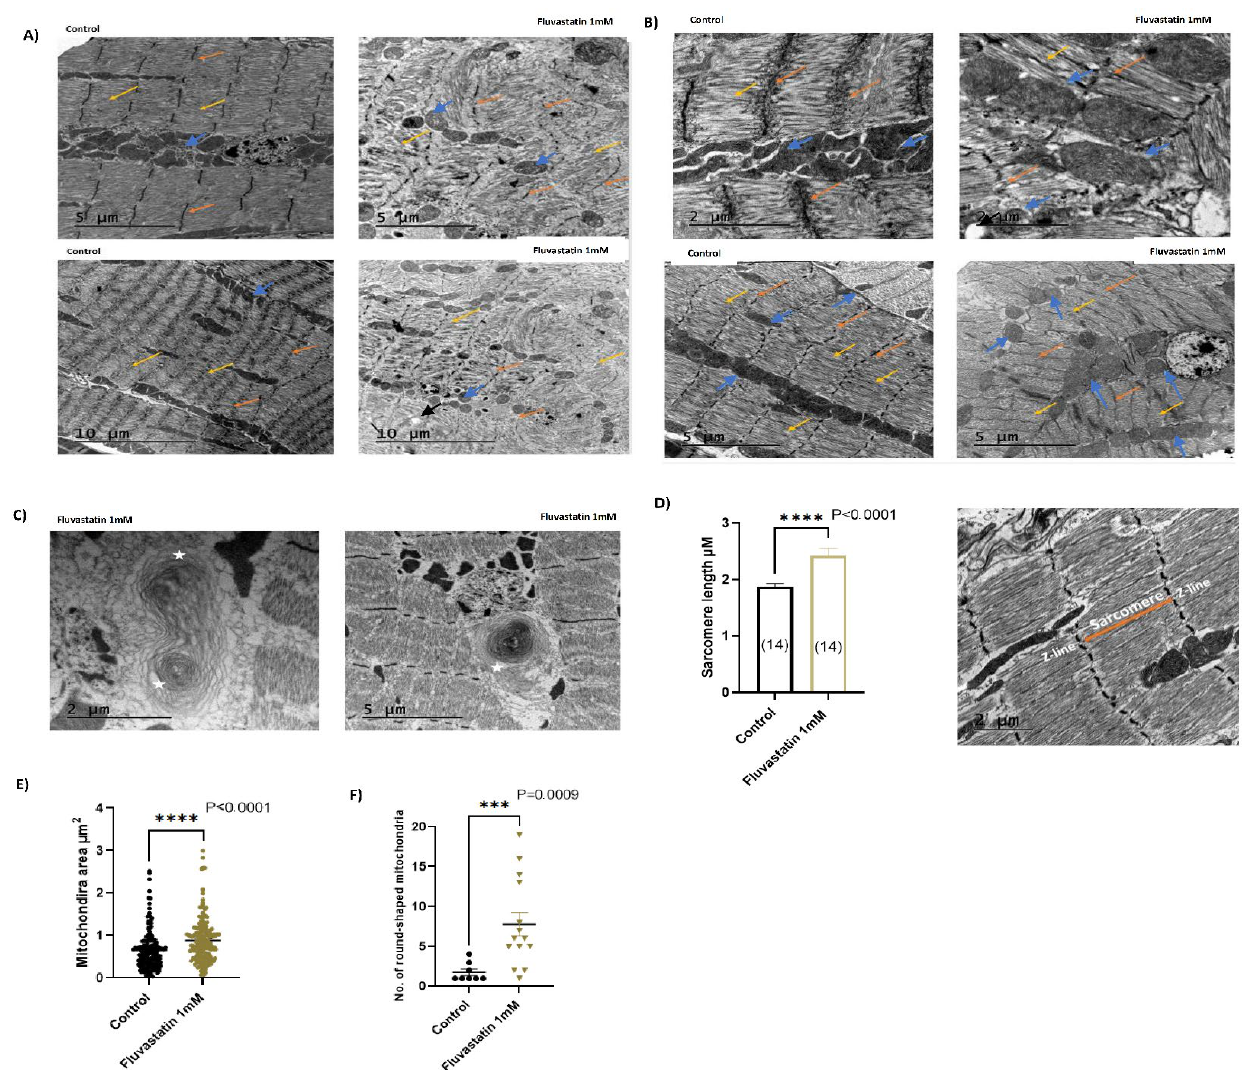
Figure 3. Fluvastatin induces myopathy-like phenotypes in flies. ( A , B ) TEM micrographs for the morphology for the longitudinal section of the dissected skeletal muscles of the femur segment of CSORC fly legs, wherein the fluvastatin group, CSORC flies were treated with 1.0 mM fluvastatin while the control group was fed with food, both for five days. Compared to the control group, the muscles of the fluvastatin group showed pronounced abnormal myofibril architecture including distorted sarcomere, Z-line streaming, and very few vacuoles, as well as more fragmented mito- chondria with different shapes and sizes. The orange arrow indicates sarcomere, yellow indicates Z line, black indicates vacuoles and blue indicates mitochondria. ( C ) Micrographs show myelinic figures (stars) similar to toxic myopathy in the fluvastatin group. ( D ) Using ImageJ software, we measured the sarcomere length between two adjacent Z-lines. On the left, the histogram shows the sarcomere length in µ m which was measured in 14 TEM micrographs for each group (fluvastatin and control). On the right is a representation of the way the sarcomere length was measured. ( E ) Using ImageJ software, we traced the mitochondria area in selected TEM micrographs. The histogram represents the area of mitochondria in µ m 2 where the dots represent the number of mitochondria. ( F ) Using ImageJ software, we counted the number of round-like shaped mitochondria in TEM micrographs where the dots represent the number of mitochondria in each micrograph. In each histogram, the bars represent the mean values ± SEM. The Shapiro–Wilk test was used to check normality. Accordingly, for normally distributed data, Student’s t -test was used to calculate statistical significance and Mann–Whitney test for otherwise data whereby *** p ≤ 0.005; **** p ≤